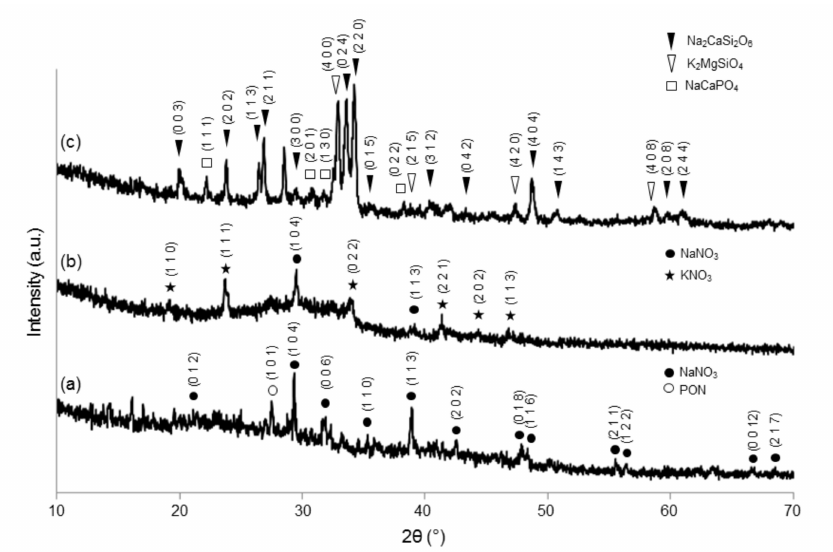
Figure 3. XRD pattern evolution upon thermal treatment of sol-gel 47.5B system at di ff erent stages of the synthesis process: DG-120 ( a ), SG-625 ( b ) and SG-800 ( c ).